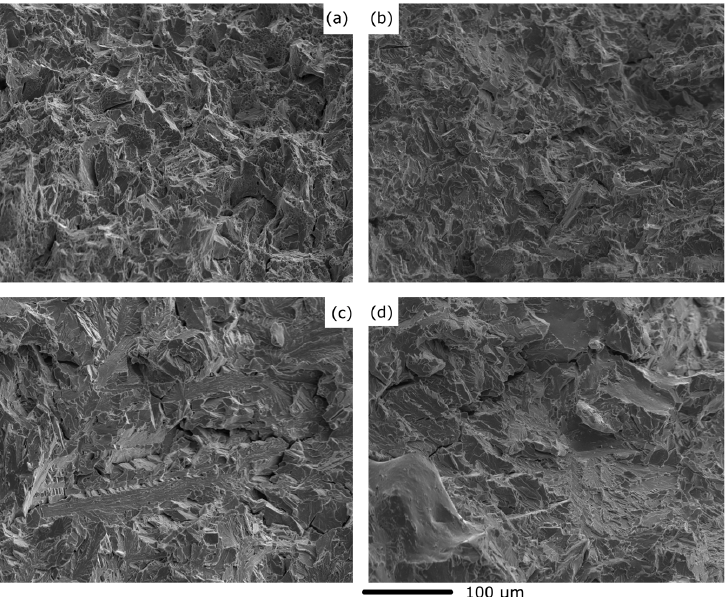
Figure A1. Fracture surfaces of samples after room-temperature tensile tests. ( a ) HT3 19; ( b ) HT5 19; ( c ) HT3 50; ( d ) HT5 50.